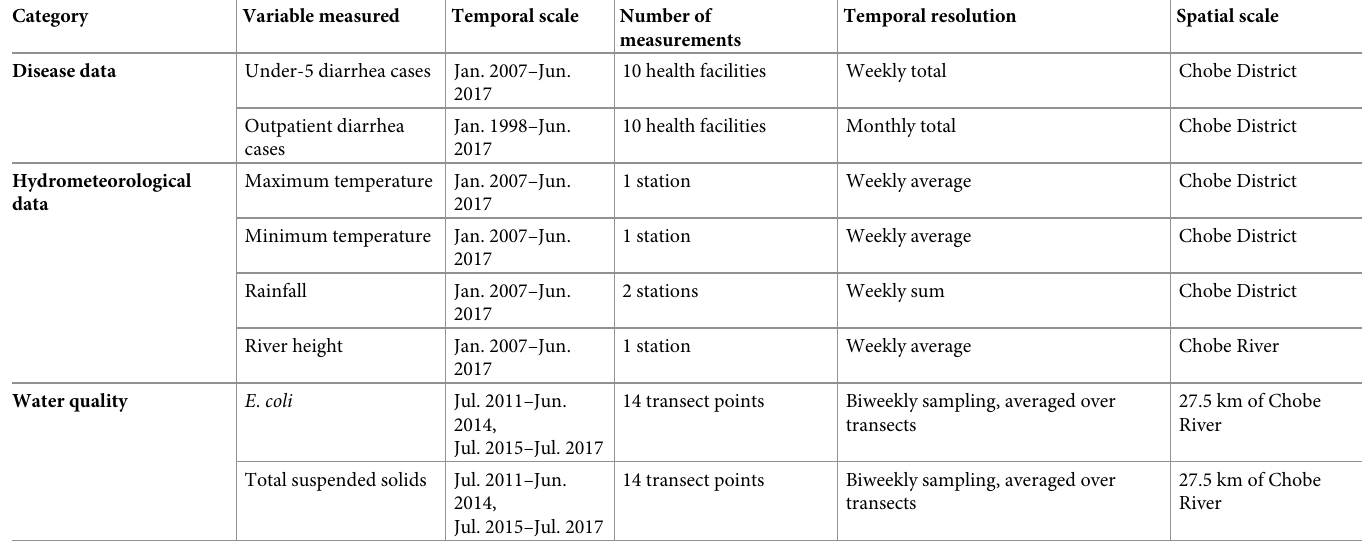
Table 1. Data type and resolution used in the